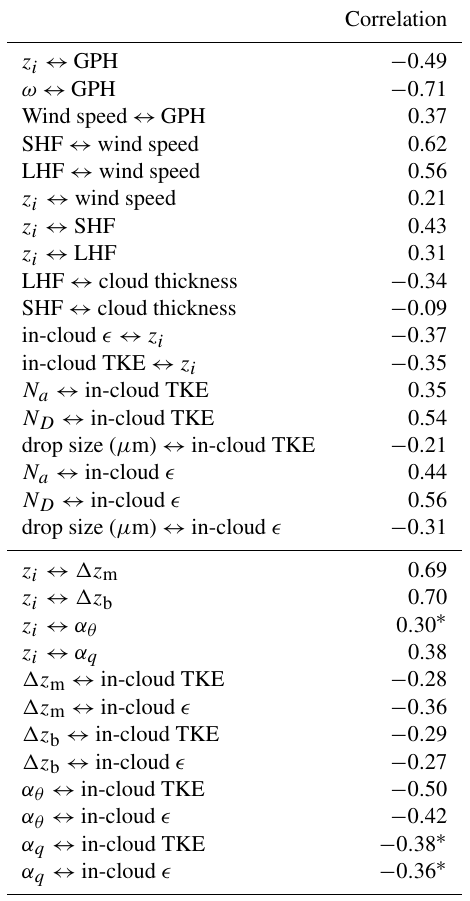
Table 4. Correlation coefficient values in the right column and vari- ables in the left column, with ↔ dividing the variables being com- pared. GPH is geopotential height (i.e., a proxy for pressure). Val- ues with ∗ were calculated excluding RF11 and RF12 due to the increase in mixing ratio above z i , resulting in abnormally large α q